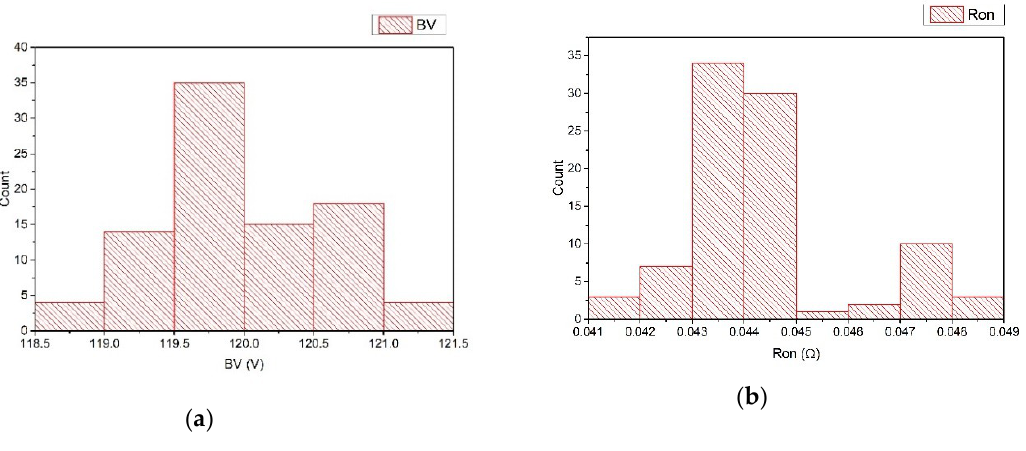
Figure 2. Test results for 90 randomly selected devices: ( a ) Breakdown voltage results; ( b ) On- Test results for 90 randomly selected resistance results.